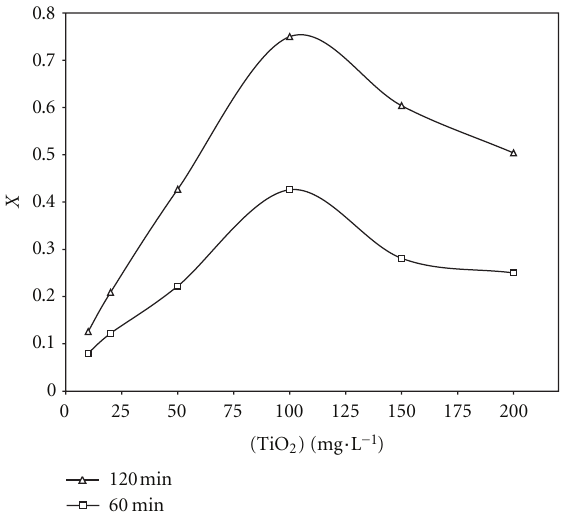
Figure 3: E ff ect of temperature on degradation, pH = 3 and [TiO 2 ] = 100 mg · L − 1